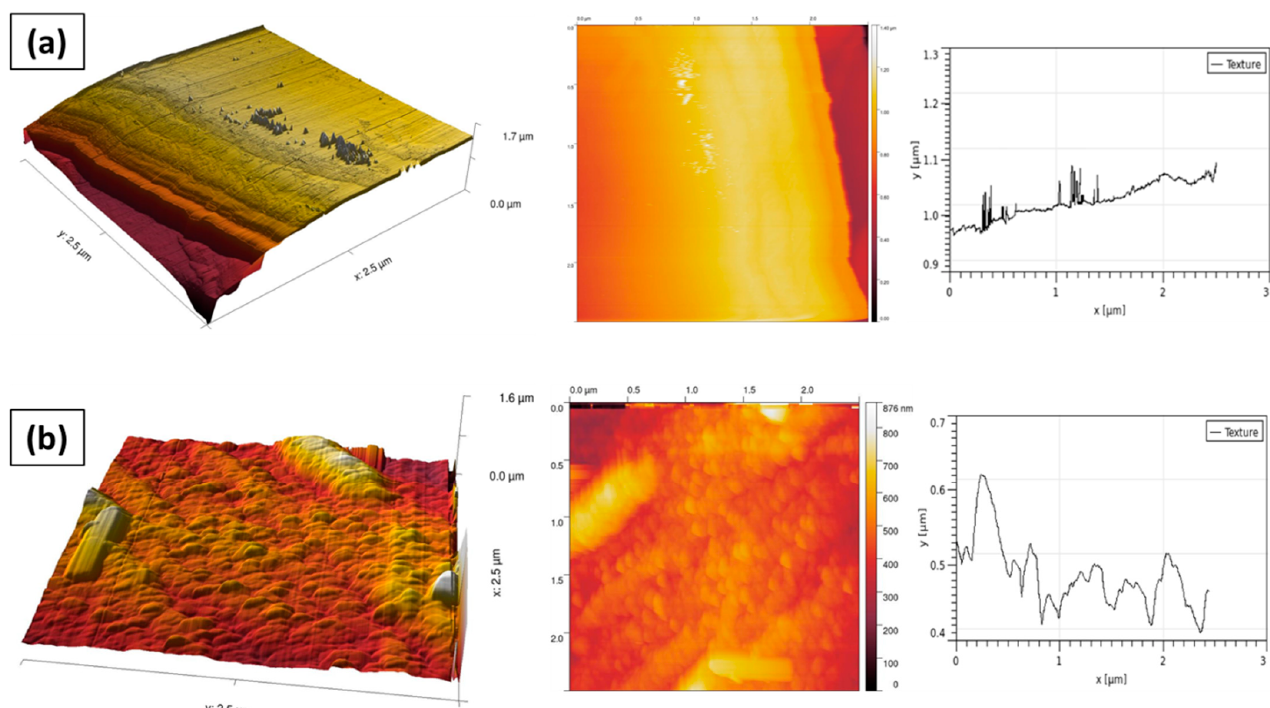
Figure 5. 3D and 2D AFM images and representative surface profiles of ( a ) pristine cotton fabric, and ( b ) ZnO-nanorod- coated cotton fabric.